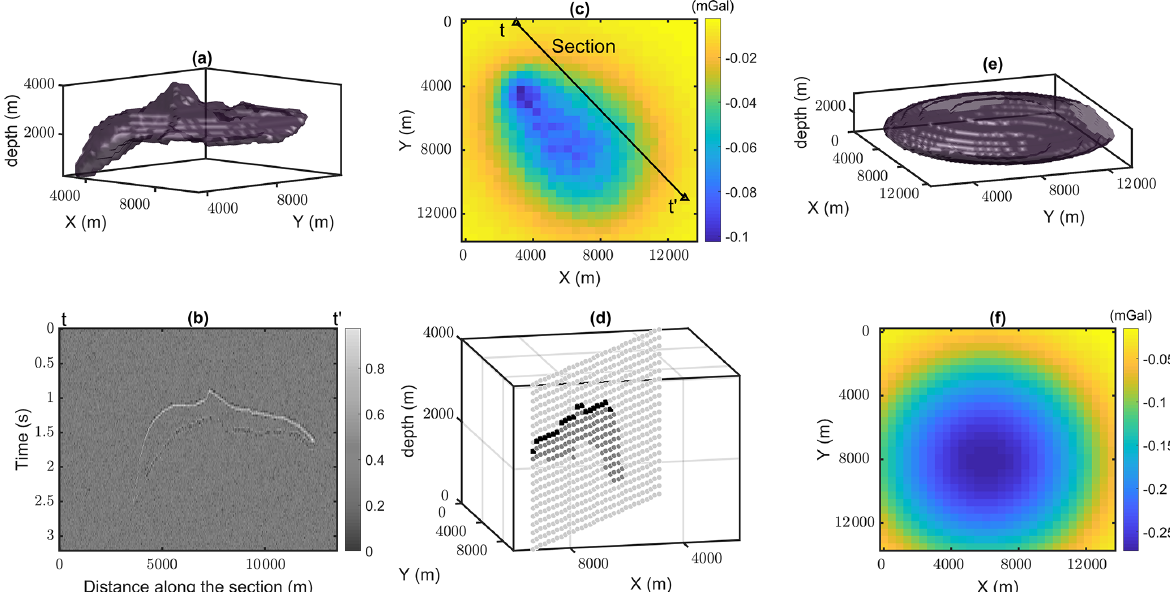
Figure 2. (a) Simplified SEG/EAGE salt model in 3D. (b) Generated synthetic seismic along section shown in (c) . (c) Forward-calculated gravity data of the true model on the surface with 5% noise. (d) Extraction of the model along the seismic line to construct the constraining matrix, the black cubes represent the location of indices of the constraining matrix with the maximum weight (400) based on the seismic image. (e) Starting model for the inversion and (f) the calculated forward gravity data of the starting model.